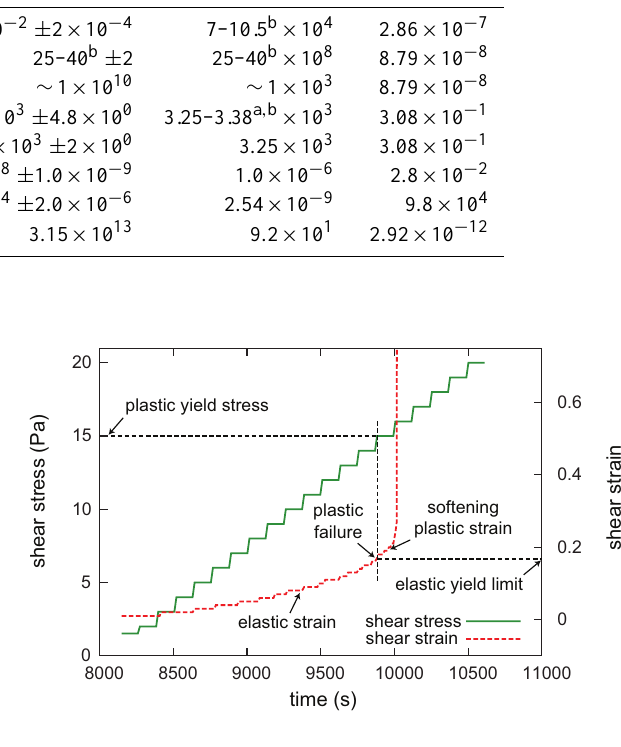
Fig. 2. Procedure employed to measure the material’s mechanical properties. A constant shear stress is imposed on the sample during each time step, and then ramped up. For low shear stresses, the shear strain increases synchronously with the shear stress increase and then remains stable. When the plastic yield stress has been reached, the shear strain increases rapidly during the constant-stress creep